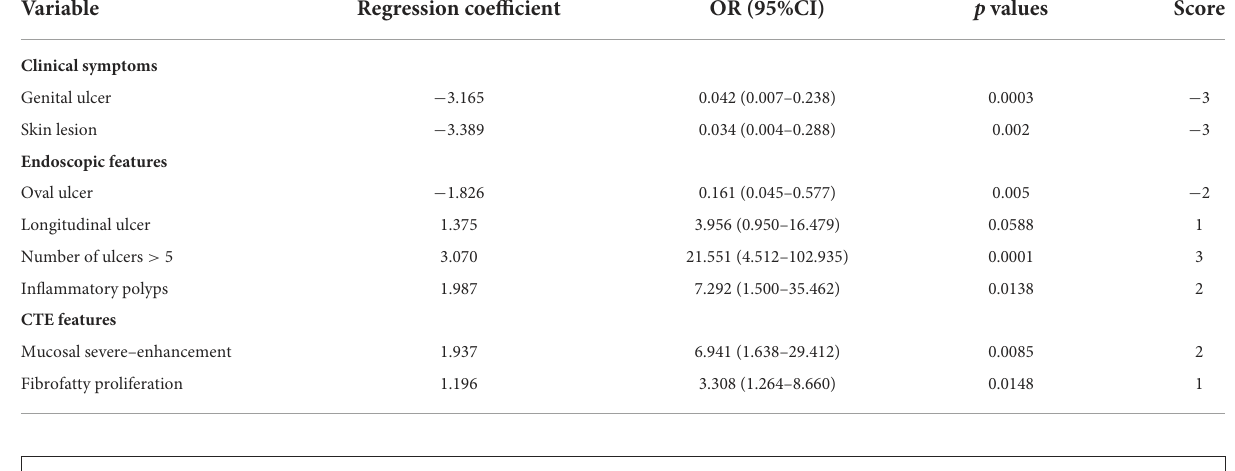
TABLE 8 The multivariate logistic regression analysis and scores of model 3.